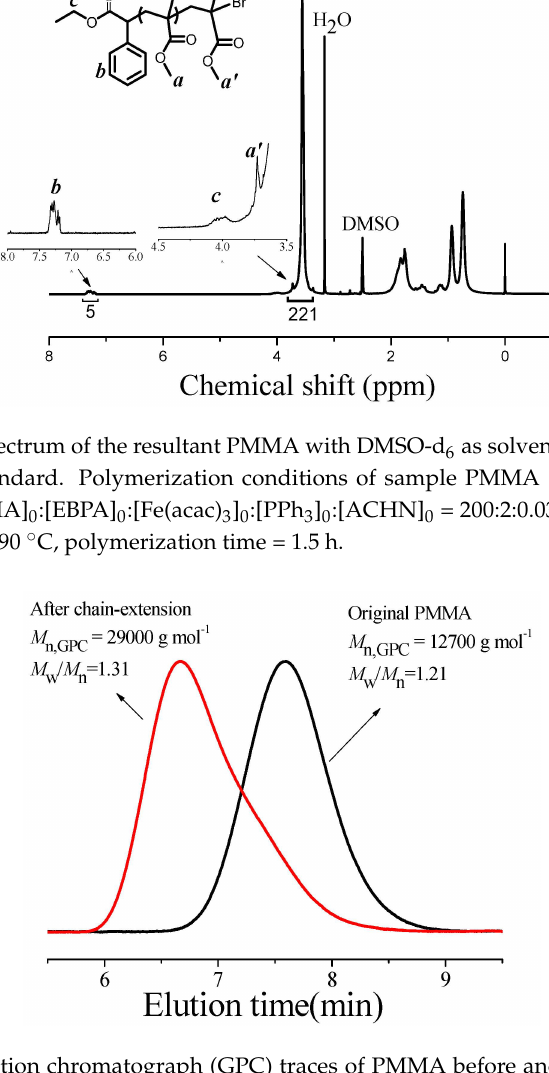
Figure 4. Gel permeation chromatograph (GPC) traces of PMMA before and after chain extension. Chain extension polymerization conditions: [MMA] 0 :[PMMA] 0 :[Fe(acac) 3 ] 0 :[PPh 3 ] 0 :[ACHN] 0 = 200:1:1:3:0.75, V MMA = 0.2 mL, V toluene = 1.0 mL, T = 90 ˝ C, polymerization time = 18